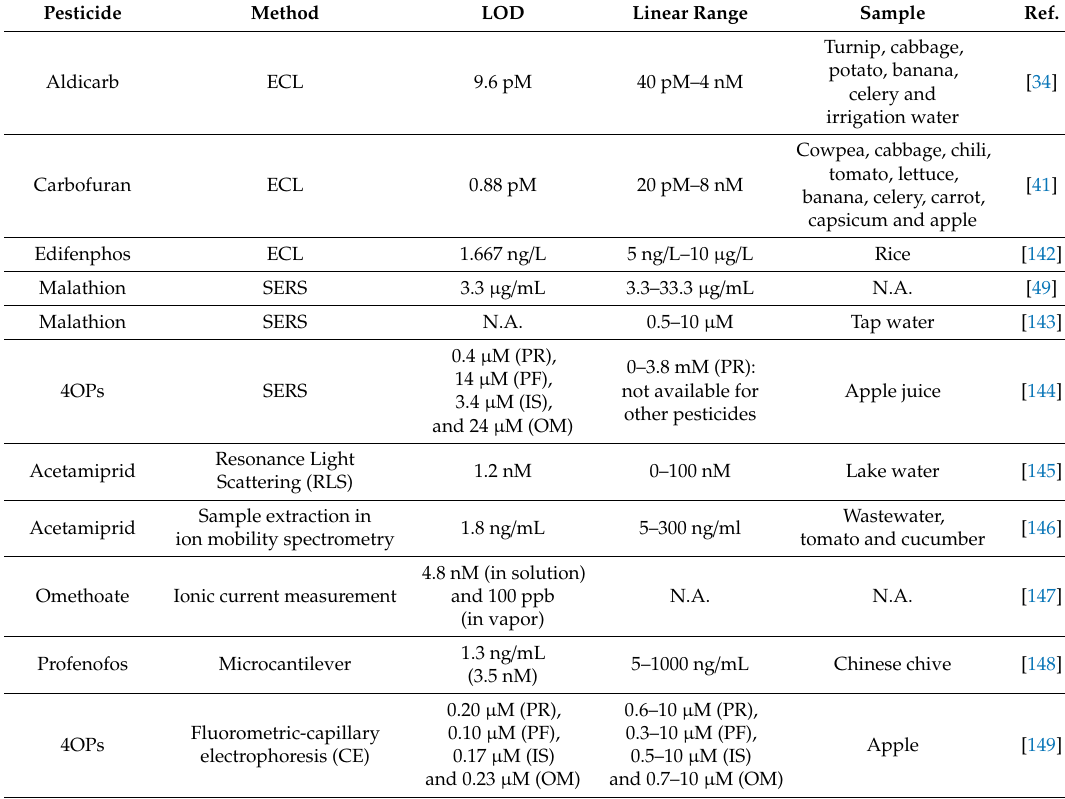
Table 5. Miscellaneous approaches with aptasensors for detection of